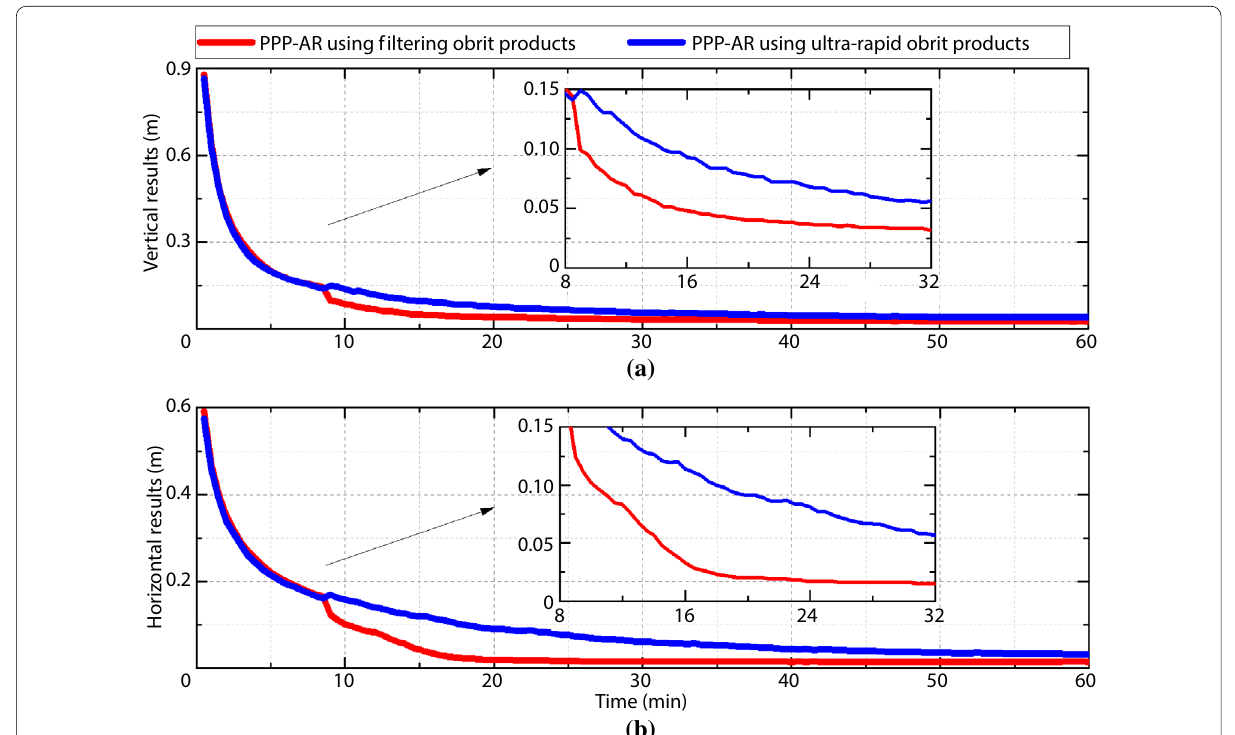
Fig. 6 Convergence series (68%) of PPP-AR with the filtering orbit products and the ultra-rapid orbit products. Subgraph a and b show the results in the vertical and the horizontal directions,